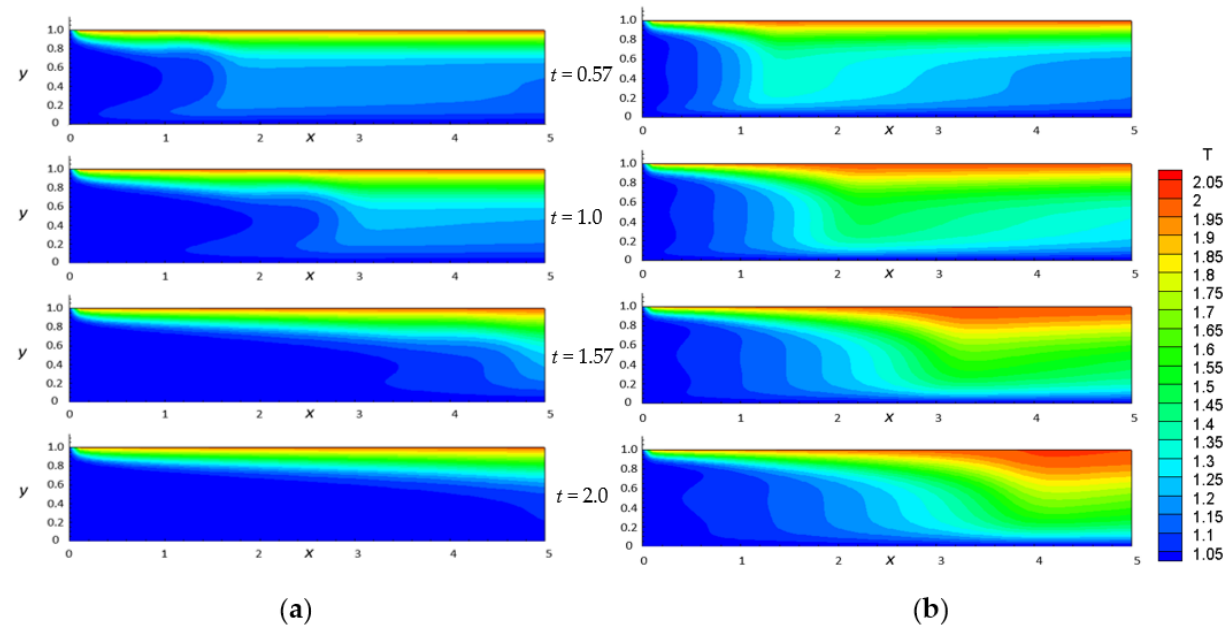
Figure 5. Time evolution of field temperature at dimensionless times 0.57, 1.0, 1.57 and 2.0 for a Stuart number of ( a ) N = 0 ( b ) N = 10.